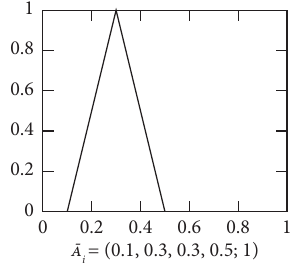
Figure 1: A Z -numbers in the 6 sets. i of